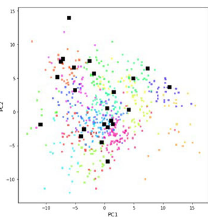
Fig. 5 K-means clustering on the fi rst four principal components of the molecular descriptor set for 365 commercial monodentate phosphines. The chemical space is represented by a two-dimensional plot of the fi rst two principal components. Each cluster is represented by color and highlighted boxes indicate selected ligands. Selected ligand structures are provided in Fig.